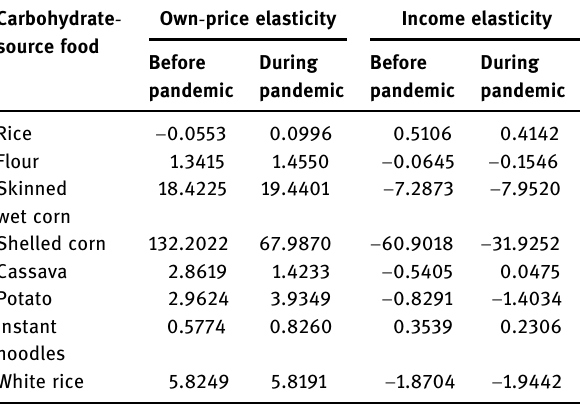
Table 3: Own - price elasticity and income elasticity Carbohydrate - source food